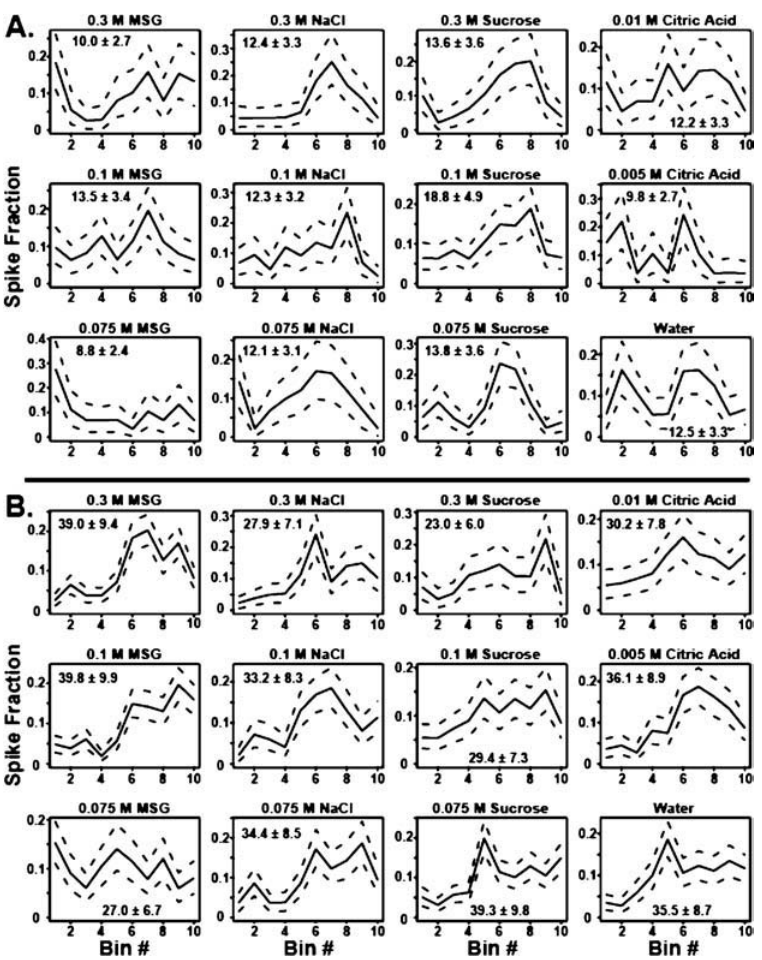
Figure 2. Partitioning single neuron firing patterns into rate and temporal components. (A) This set of 12 panels depicts the way in which the firing patterns of a single unit were decomposed into temporal and rate components. Each graph represents the neuron’s temporal response to one concentration of a particular tastant. The abscissa corresponds to the bin number within the 150ms window following tastant delivery. Each bin represents 15ms. The fraction of spikes that fall into each bin is given on the ordinate. The average proportion of spikes that fall in each bin is depicted as the solid black line, and 10th and 90th quantiles for the averages are shown as the dashed lines. The average firing rates (spikes/seconds) and SEMs for each tastant are also presented. The temporal patterns for the 0.1 and 0.3M sucrose exhibit substantial overlap and therefore are not significantly different, but the average firing rates do differ significantly. For 0.1 and 0.3M NaCl, the temporal patterns differ substantially in their peak response times, but the firing rates for these stimuli are not significantly different. (B) In the case of 0.075 and 0.3M MSG, both the temporal profiles and the firing rates for this neuron are significantly different. In contrast, note that firing rates for 0.1 M MSG and 0.075M sucrose are the same but that the associated temporal profiles are very different.